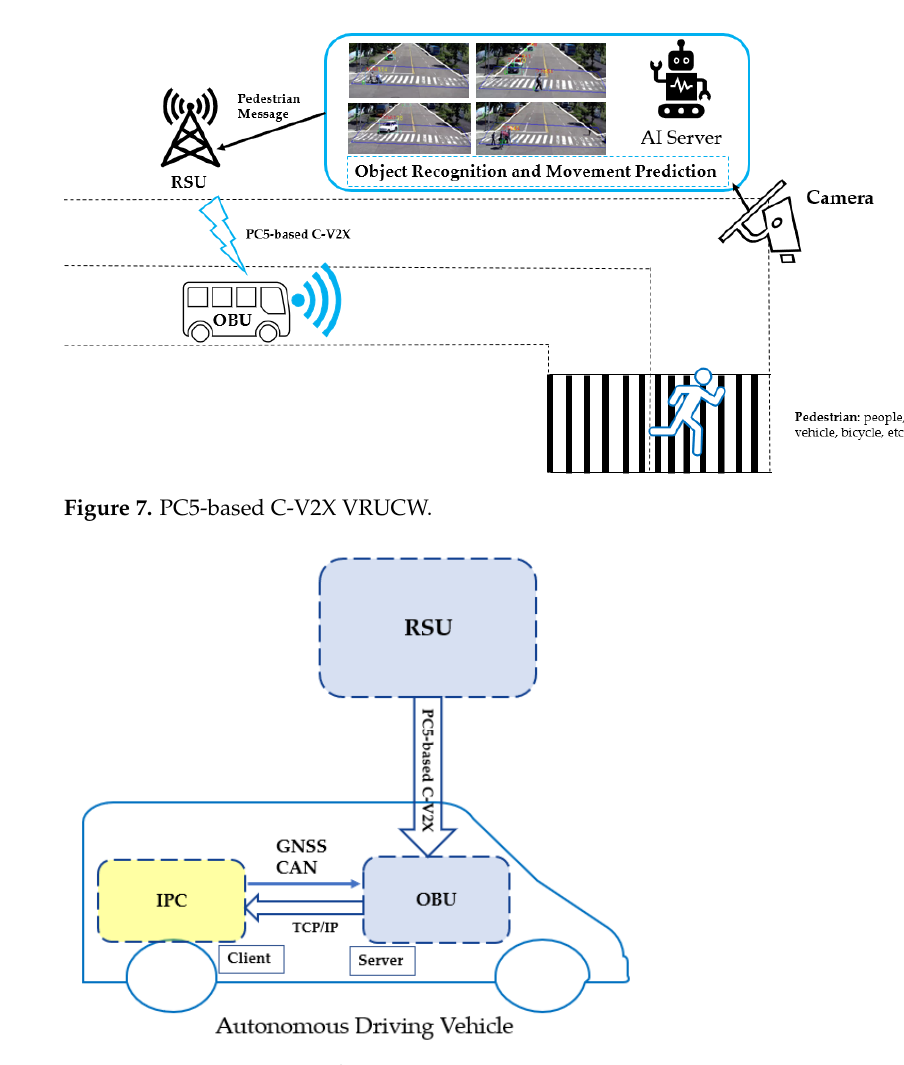
Figure 8. C-V2X Automated Driving System